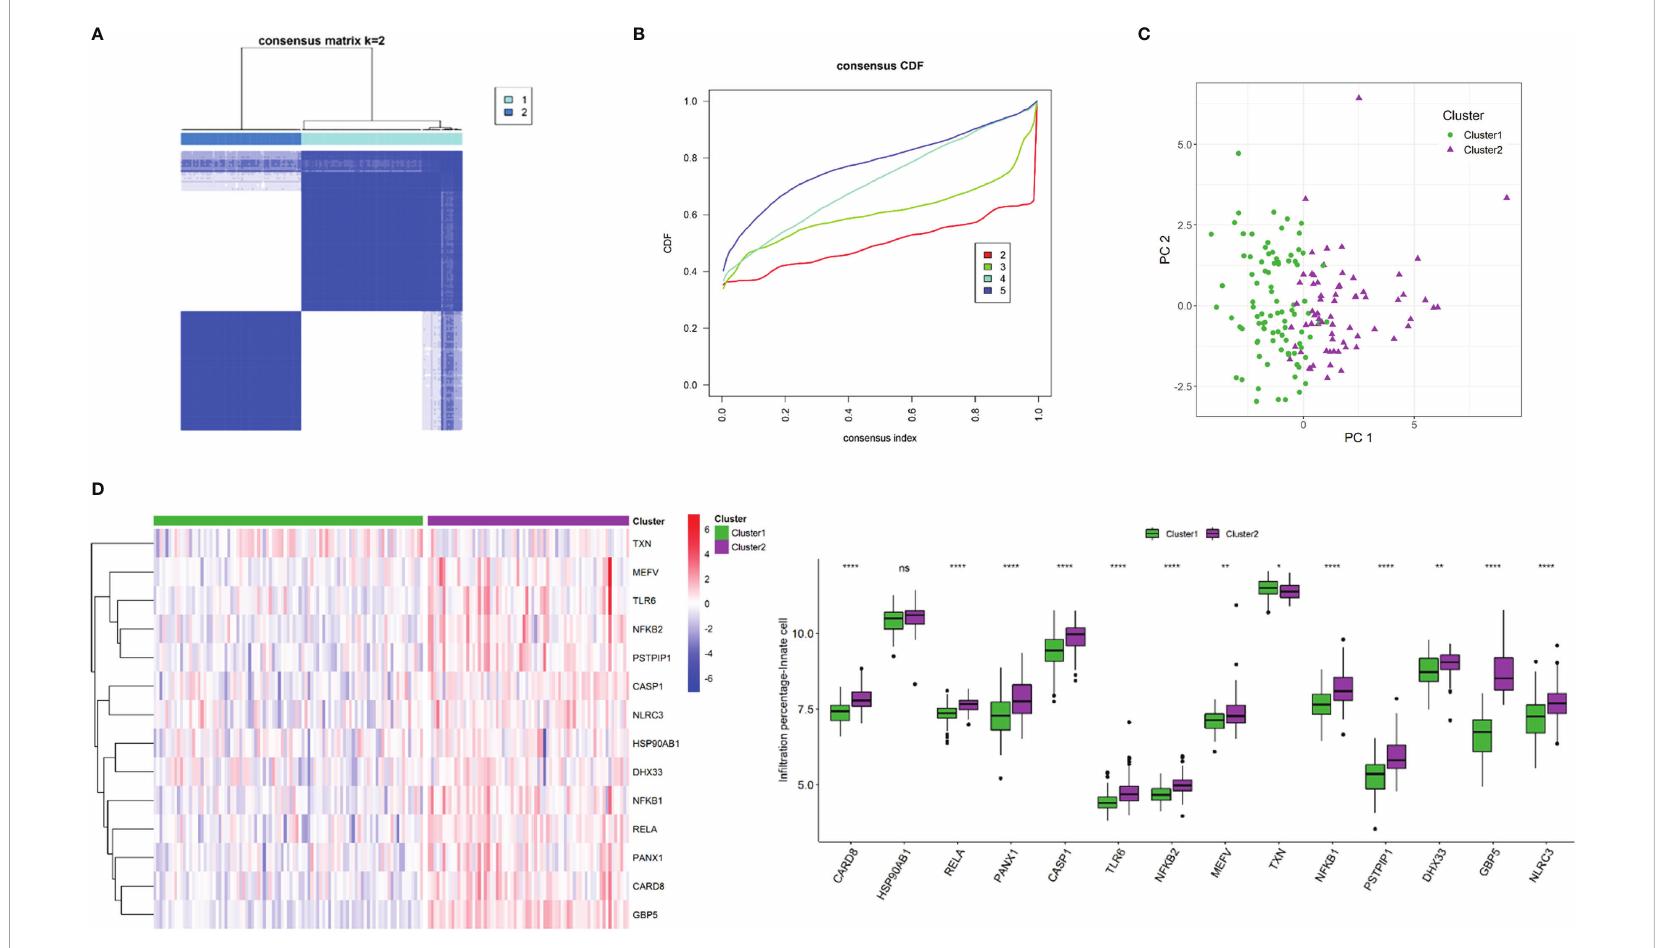
FIGURE 8 NLRP3 in fl ammasome-related gene-based classi fi cation of Crohn ’ s disease. (A) Unsupervised consensus clustering matrix and optimal clusters. (B) Item-consensus plot showing the relationship between each cluster. (C) Principal component analysis (PCA) based on clustering results. (D) Heatmap and box plots demonstrating expressions of NLRP3 in fl ammasome-related genes in each cluster. ns: P ≥ 0.05; *: P < 0.05; ** P ≤ 0.01; **** P ≤